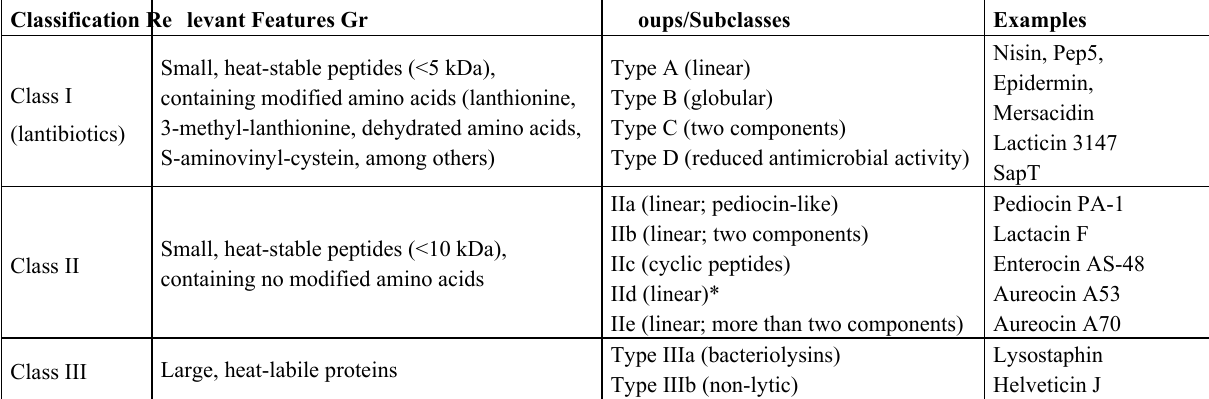
Table 1. Classification scheme for bacteriocins produced by Gram-positive bacteria proposed by Sahl & Bierbaum [2] and Nissen-Meyer et al. [3], with